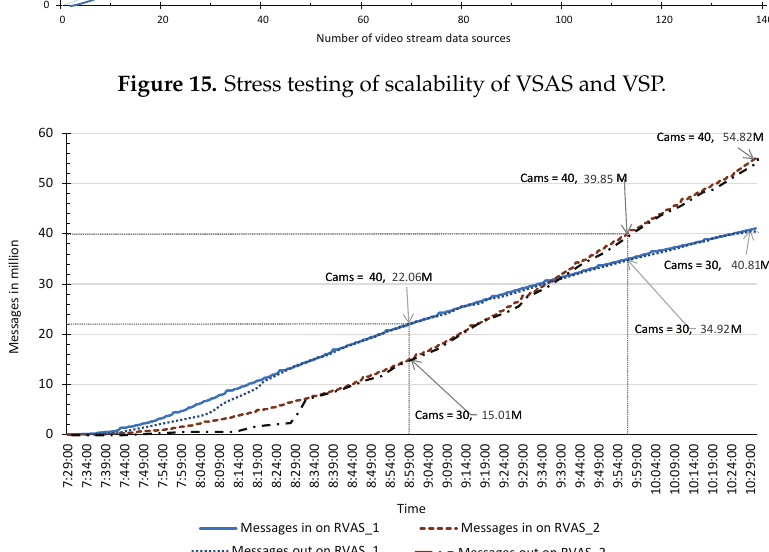
Figure 16. VSAS and VSP performance in production